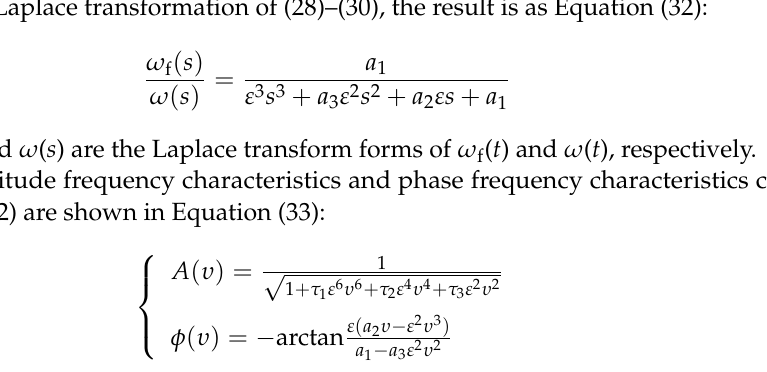
Figure 5. Solution of angular acceleration signal and angular velocity signal after noise suppression. The noise of the signal exists in the input term ω ( t ). From Figure 5, it can be seen that the input term only exists in the lowest differential Equation (30). β ( t ) and ω f ( t ) are obtained by two and three times integral of d α ( t )/d t , respectively. The integral is not sensitive to noise. Therefore, the integral chain differentiator structure shown in Figure 5 can effectively suppress the noise in the sampling signal. The following theoretical analysis was carried